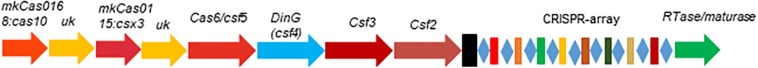
Schematic representation of type IV-like CRISPR-Cas system in plasmids found in Enterobacteriaceae. Putative genes are identified. CRISPR associated genes (Cas) are shown in red, DinG helicase in blue, unknown/hypothetical genes in yellow. Black rectangle indicates a putative leader sequence; blue diamonds are for CRISPR-repeats and colored rectangles are for acquired spacers, together consisted CRISPR-array.